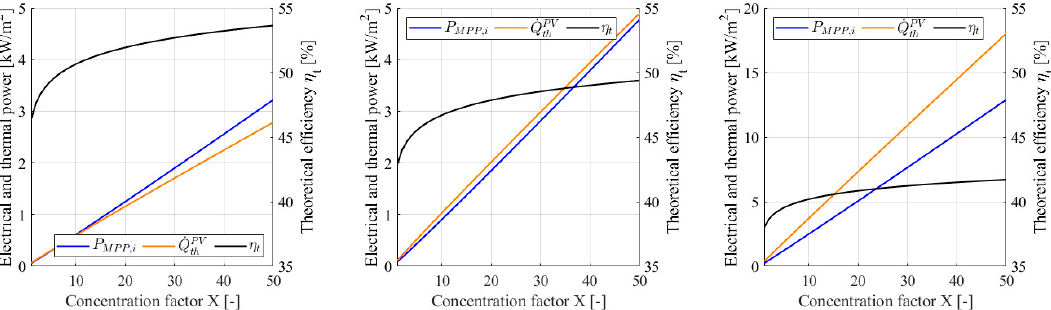
Figure 9. Key parameters of Spectral Splitting depending on concentration factor for c-Si ( left ), CIGS ( middle ) and CdTe ( right ) PV technology.